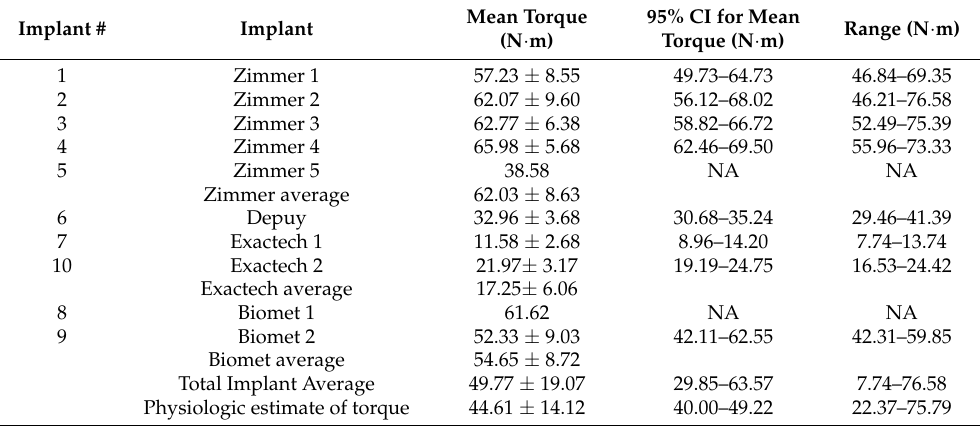
Table 4. Mean torque to